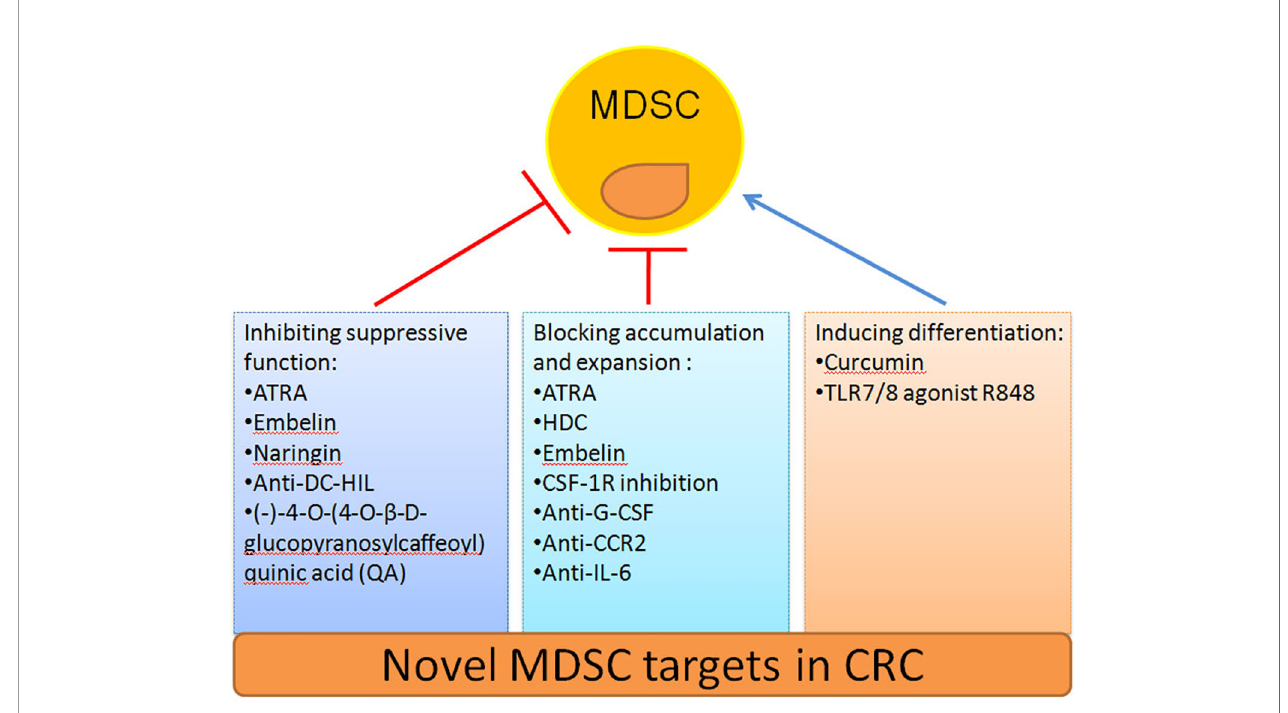
FIGURE 2 | Novel strategies to target MDSCs in